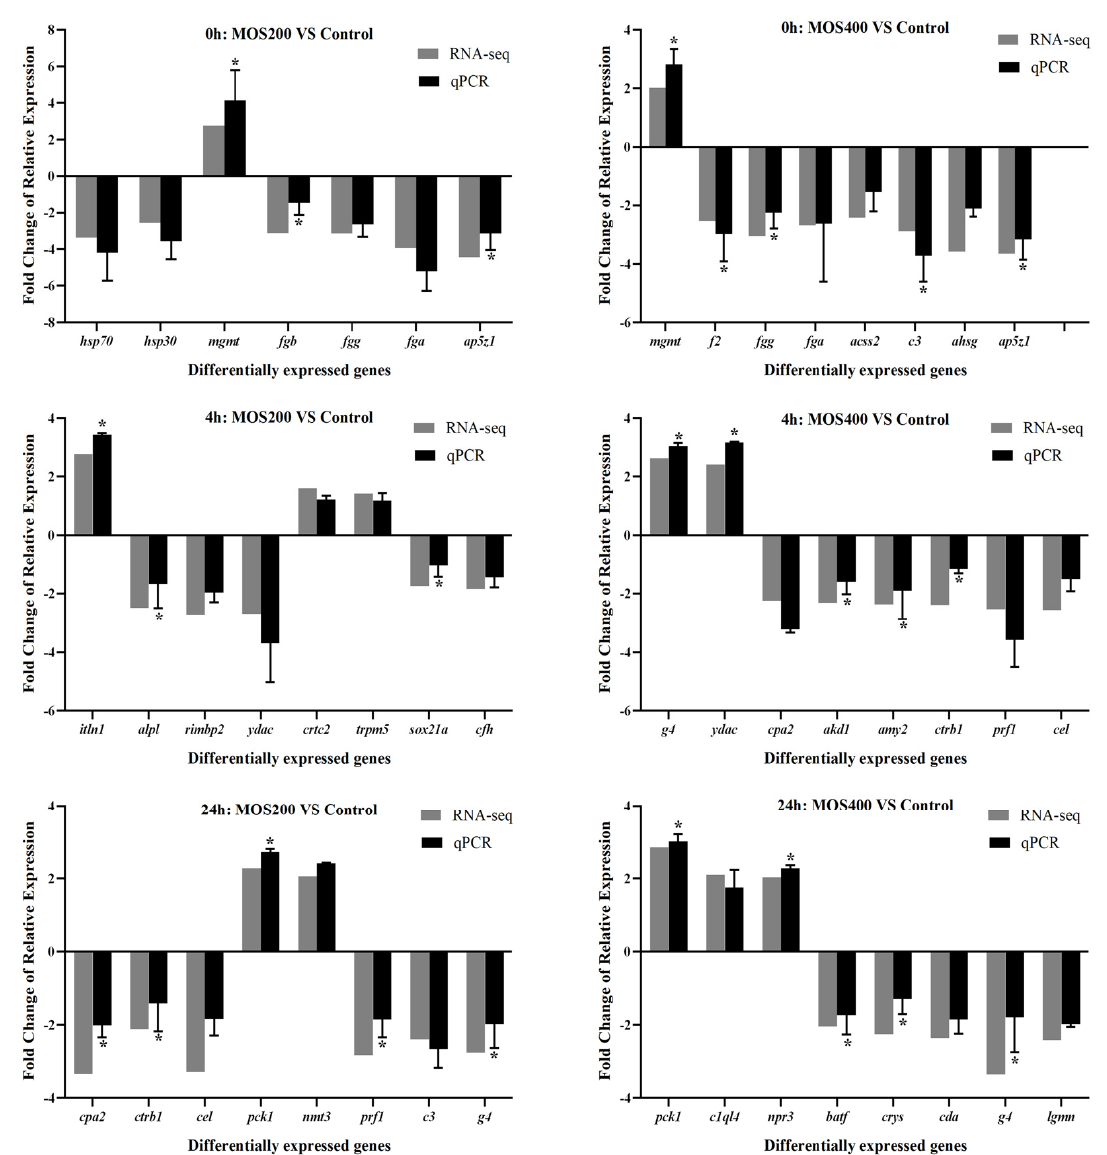
Figure 10. qRT-PCR validation of the gene expression patterns of randomly selected DEGs in the intestines of dietary MOS and control groups at different time points post-infection, and GAPDH was selected as the internal reference gene. Data were shown as mean ± SE. Asterisks indicate statistically significant differences after performing Tukey’s HSD test ( p < 0.05).